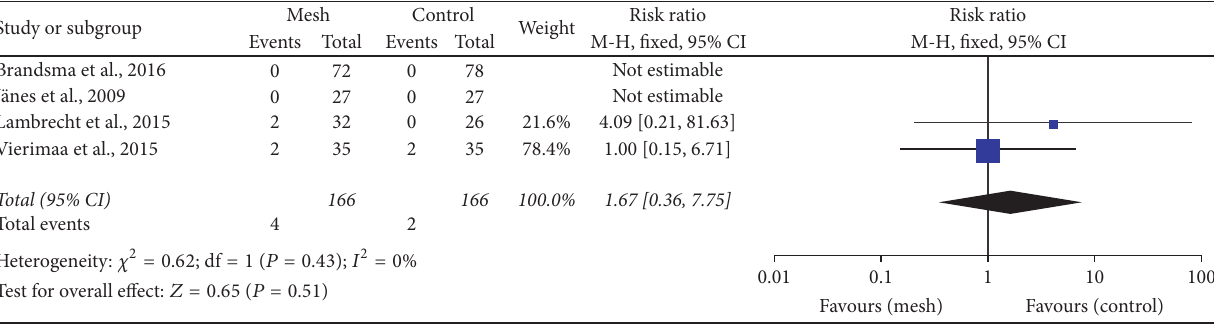
Figure 10: Forest plot for stomal